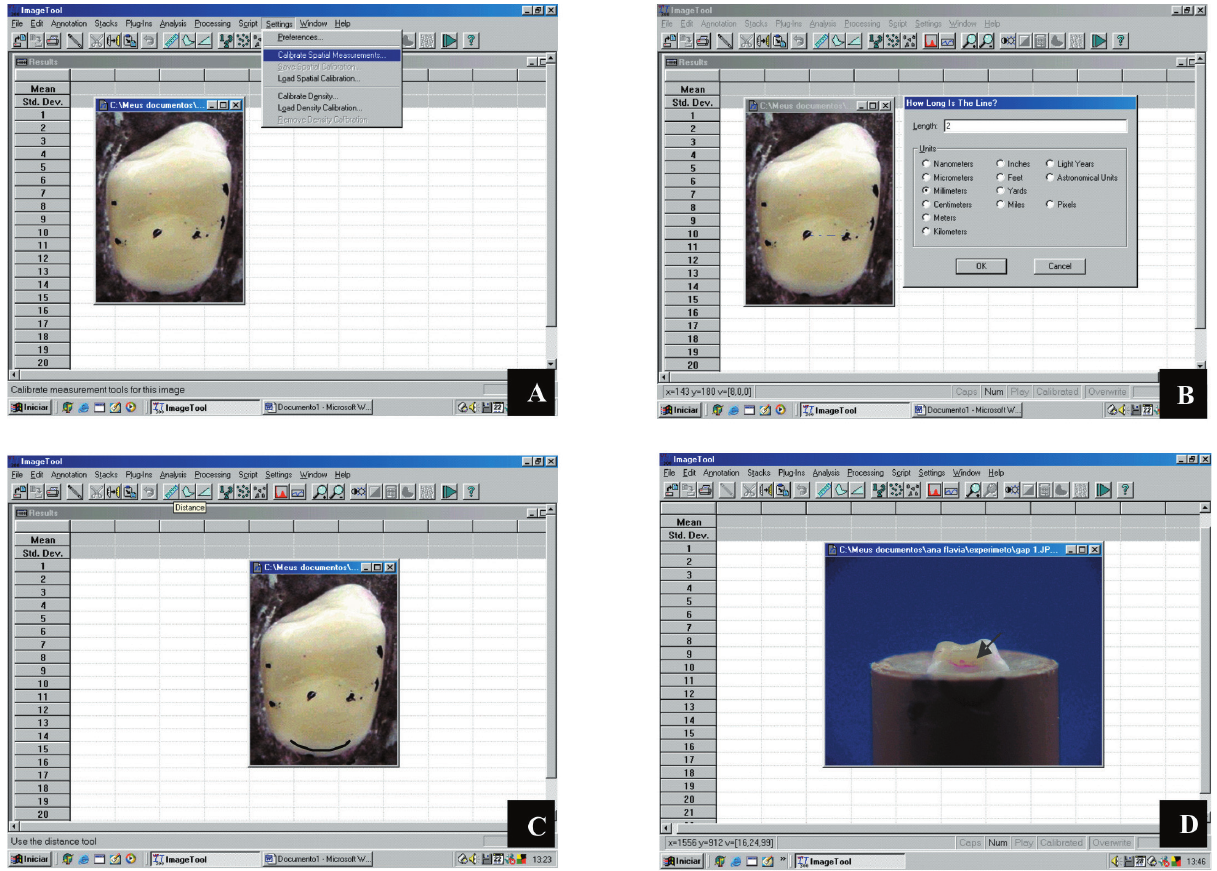
Figure 3- Sequence of gap measurements. A and B: Calibration of measurements to mm. C: Measurement of marginal restoration. D: Gap presence detected by staining area (black